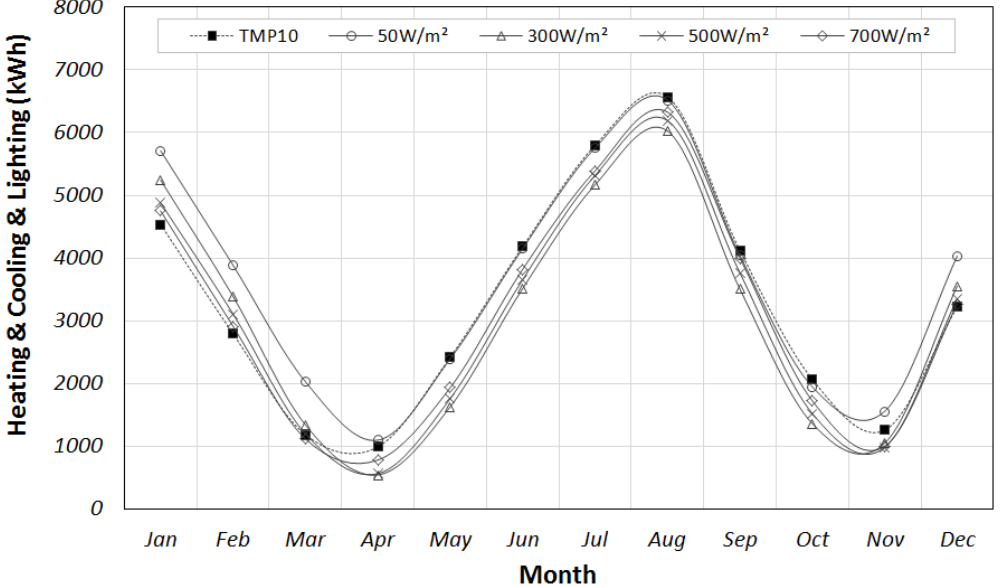
Figure 12. Electrochromic glass’ controlling conditions and monthly energy consumption rate.